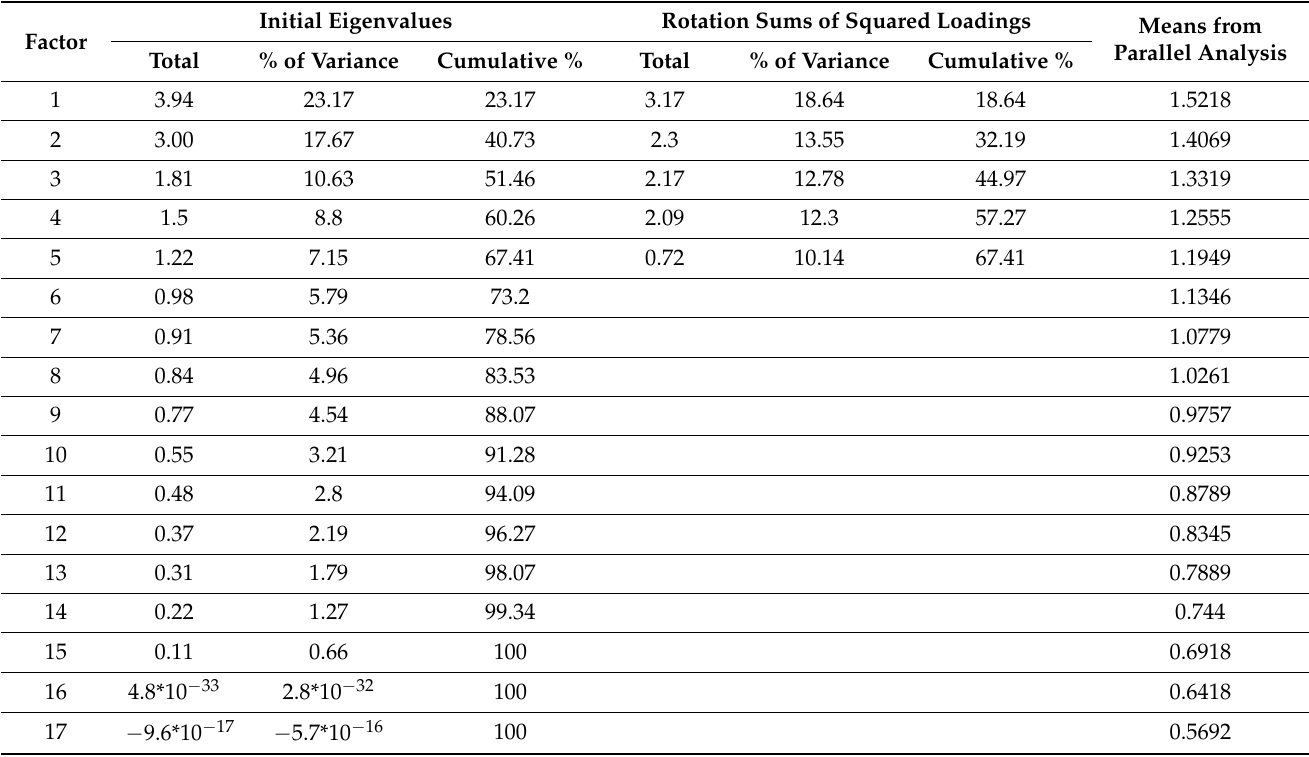
Table 3. The total variance explained with Eigenvalues using EFA.